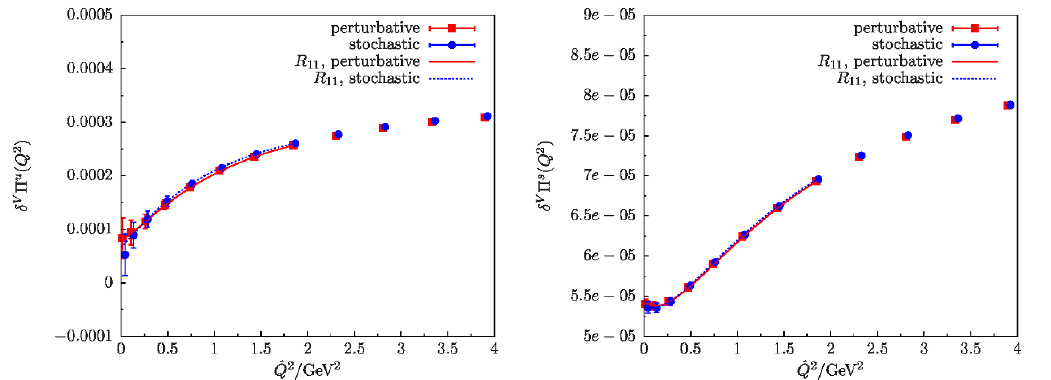
Figure 12 . The QED correction (cid:14) V (cid:5)( ^ Q 2 ) to the HVP for the up quark (left) and the strange quark (right). The blue dashed line and the red solid line shows results of a Pad(cid:19)e (cid:12)t of the form (5.17) to stochastic and perturbative data,